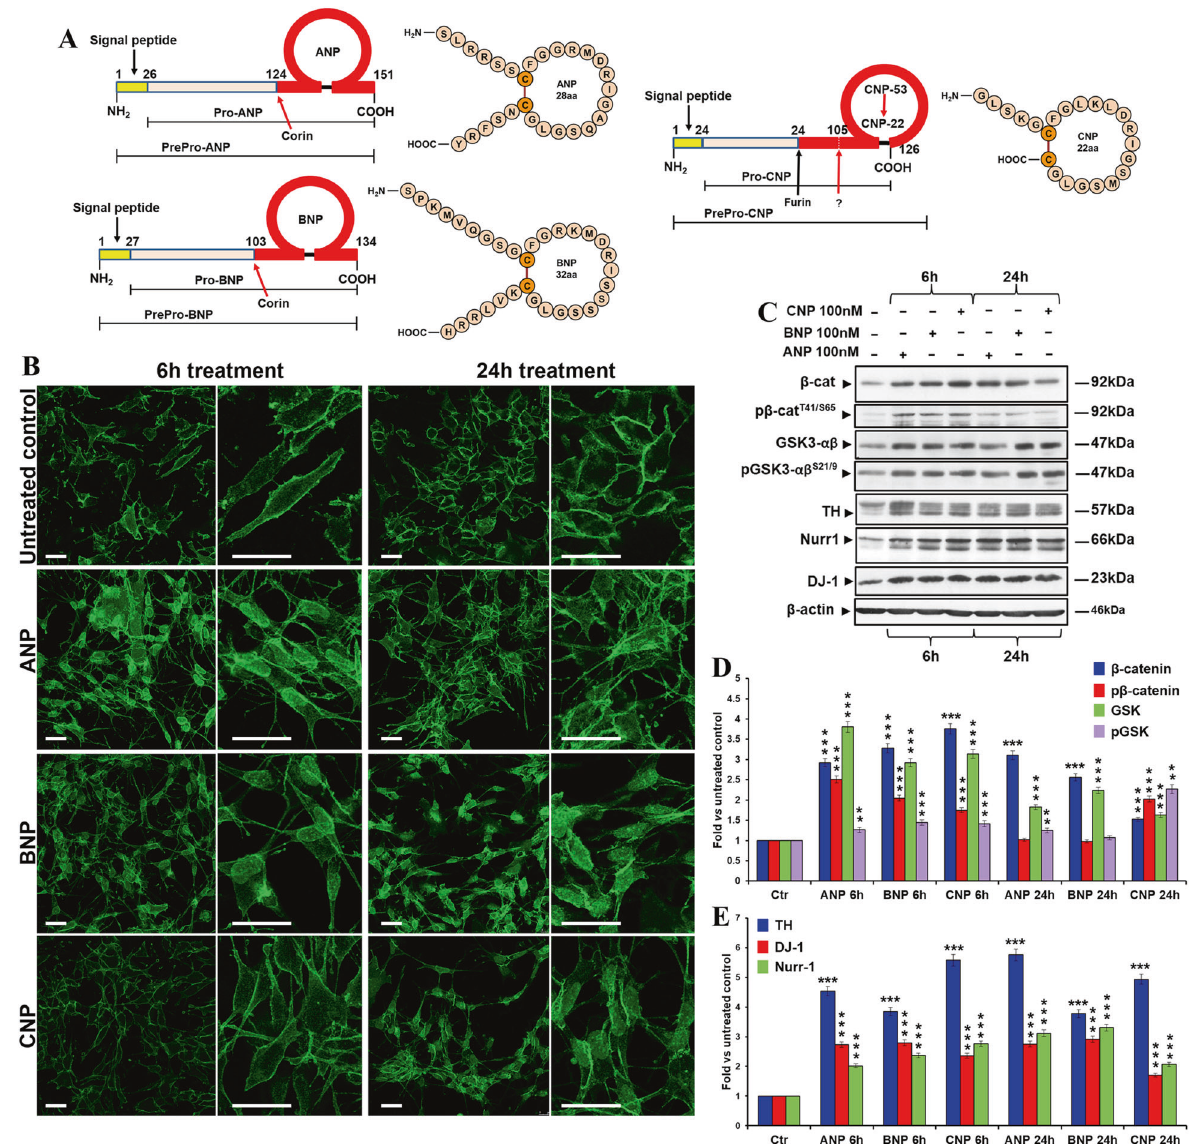
Fig. 1 NPs induce β -catenin stabilization and nuclear translocation and affect DA neuron markers and PD-related survival factors in SHSY5Y cells. A Structure of the human natriuretic peptides. Pro-ANP and pro-BNP are proteolytically cleaved to the mature forms by the membrane-associated protease Corin [43], which extracellular region, that contains the structural domains essential the processing, includes the Wnt signaling receptors Fzd1 and Fzd2 [44]. Differently, the processing of pro-CNP to its mature form occurs through the action of the intracellular serine endoprotease furin [45], which generates the 53aa biologically active peptide (CNP-53), the main active form of CNP at the tissue level. CNP-53 is then further cleaved by an unknown protease to a shorter 22aa form (CNP-22), which is the dominant form in the systemic circulation [46]. The structure of the prepro-hormones for ANP, BNP, and CNP are reported on the left of each panel, while the fi nal amino acid sequence and structure of the mature and biologically active peptides are shown on the right. The sites of cleavage operated by Corin (for ANP and BNP) and by Furin (for CNP) are also indicated. B Confocal microscopic images showing the intracellular distribution of β -catenin in control and NPs treated cells after 6 and 24 h of culture. Bars 25 µm. C WB analyses of total and phosphorylated β -catenin (p β -cateninT41/S65), total and phosphorylated GSK-3 β (pGSK-3 β Ser9), TH, Nurr-1, and DJ-1 levels in total cell lysates from NPs treated SHSY5Y cells, compared to the untreated control, after 6 and 24 h of treatment. D , E Densitometric analysis of total and phosphorylated β -catenin and GSK-3 β ( D ), and of TH, Nurr-1, and DJ-1 ( E ) using the ImageJ processing program; values were normalized to β -actin, or vs. the total levels of each protein for the phosphorylated forms. Results are the mean ± SD from three independent experiments ( n = 3). Signi fi cance vs. untreated relative control (one-way mANOVA + Tukey multiple comparison test): ** p < 0.01, *** p < 0.001. Additional results from the one ‐ way ANOVA test used to analyze the differences between groups are reported in Supplementary Data.